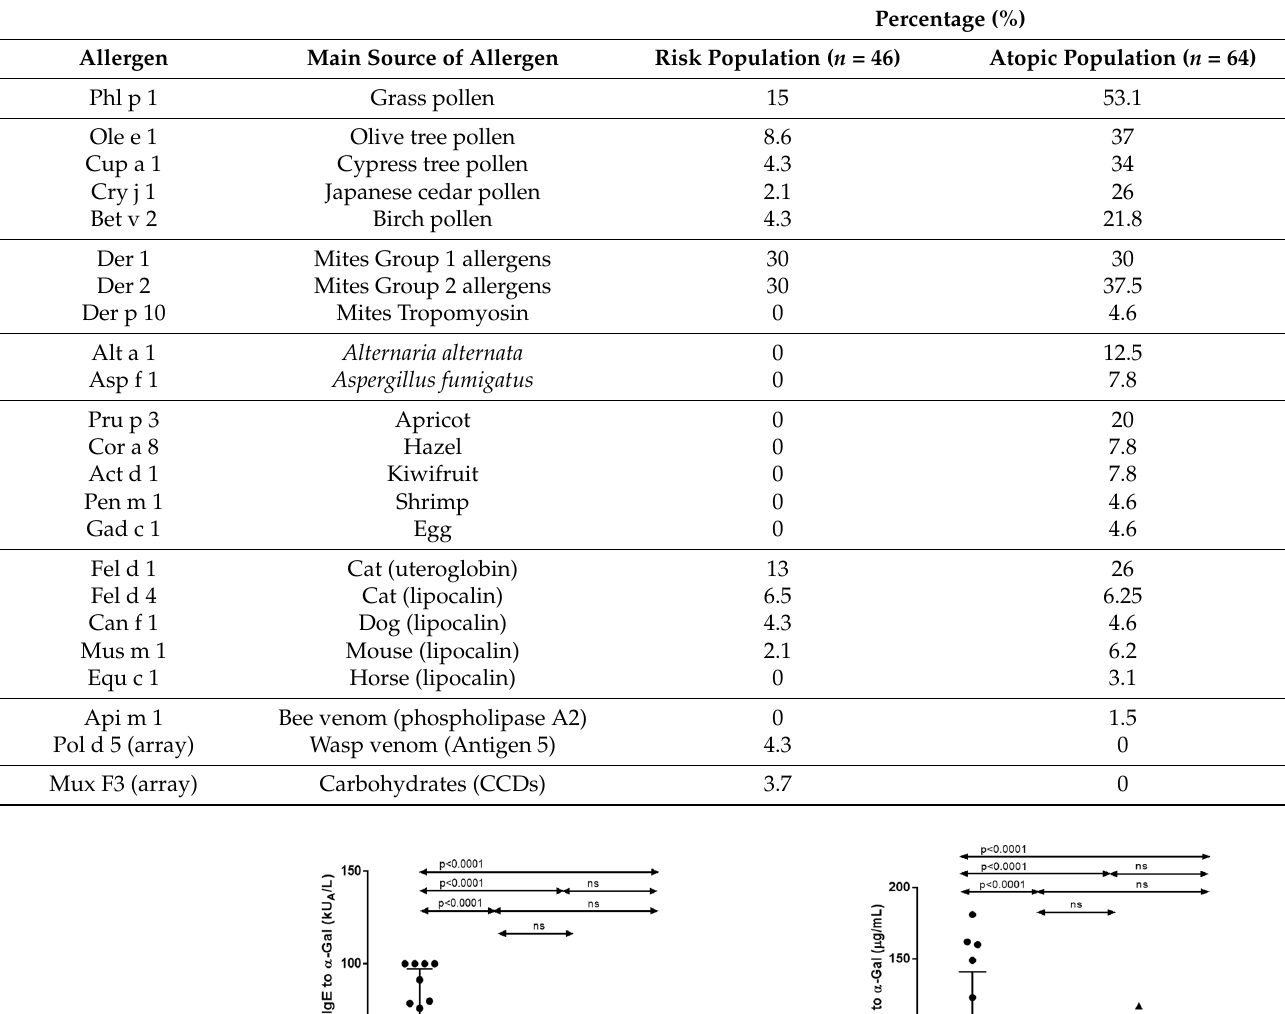
Table 3. Prevalence of sensitization in the risk and atopic population measured by ImmunoCAP ISAC. Results are expressed as percentage (%) of total number of participants.